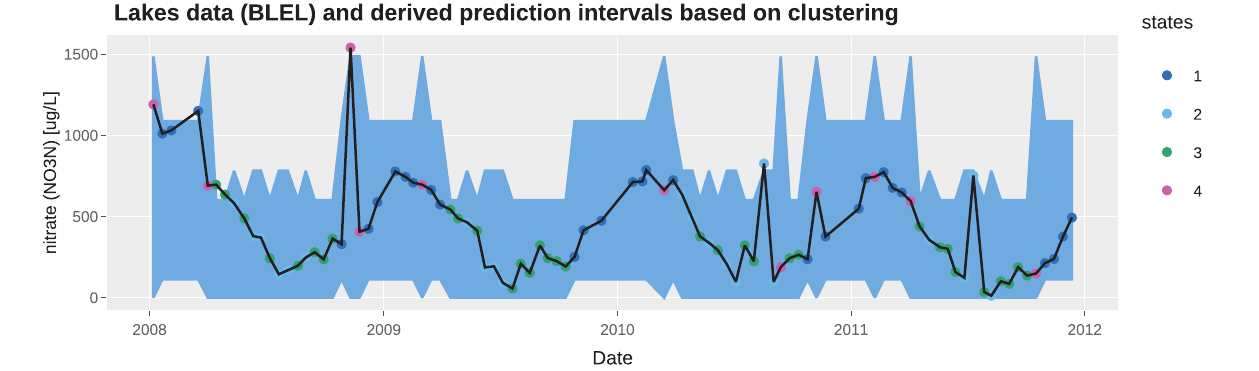
are made available. We emphasize that the meaning of the states identified by the unsupervised state tagging method is arbitrary and they do not involve specialist